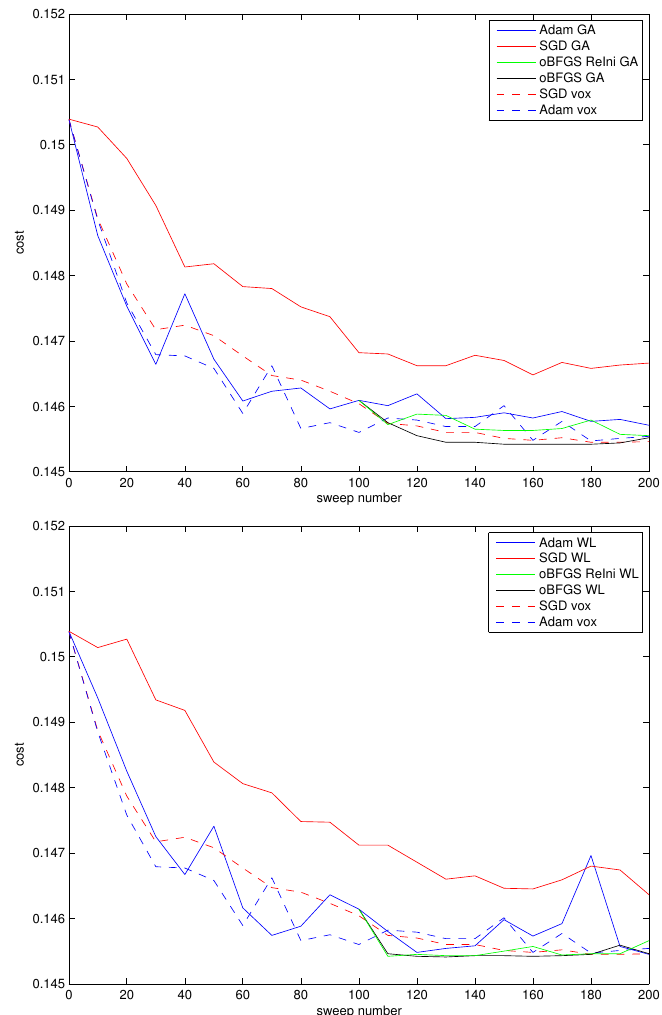
Figure 5. Cost versus sweep number doubling the extreme values of I vox . Top image: Gaussian RBF; Bottom image: Wendland RBF. The blue, red, green and black curves refer, respectively, to the following algorithms: Adam, SGD, oBFGS with reinitialization every N ReIni = 10 sweeps and oBFGS (without reinitialization). The dashed lines correspond to level set pixel-based Adam and SGD